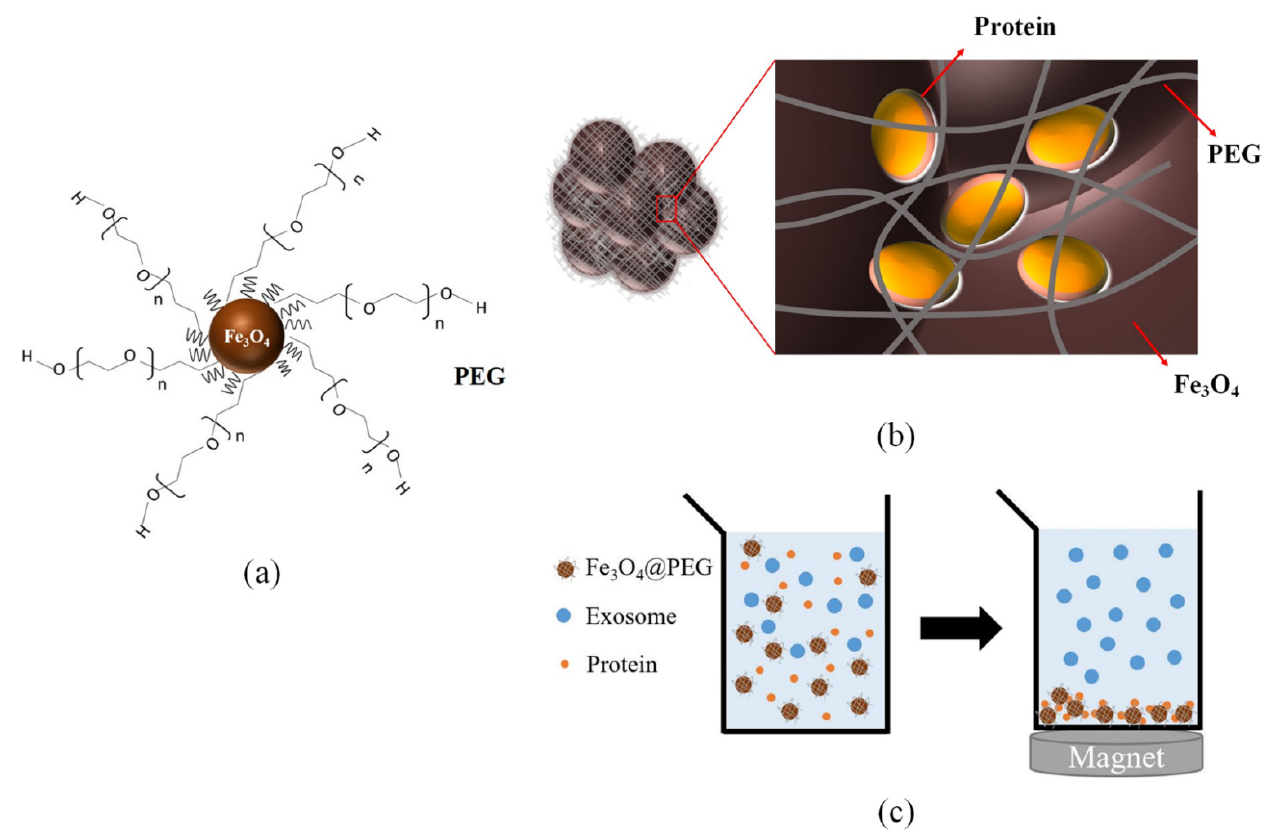
Figure 5. EV isolations by PEG-coated magnetic nanoparticles. ( a ) The structure of magnetic nanoparticles modified with branched PEG ( b ) Protein trapped by the reticular structures of PEG and the holes formed by agglomerates of magnetic nanoparticles ( c ) Proteins are removed by magnet. This figure was adopted from reference [90] .